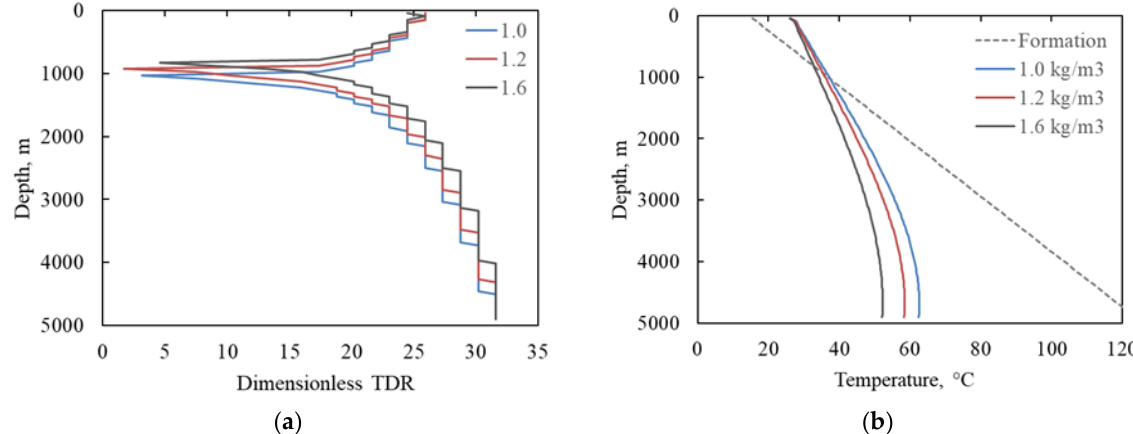
Figure 10. The sensitivity analysis of thermal disturbance with various mud densities: ( a ) TDR and ( b ) fluid temperature in the annulus.